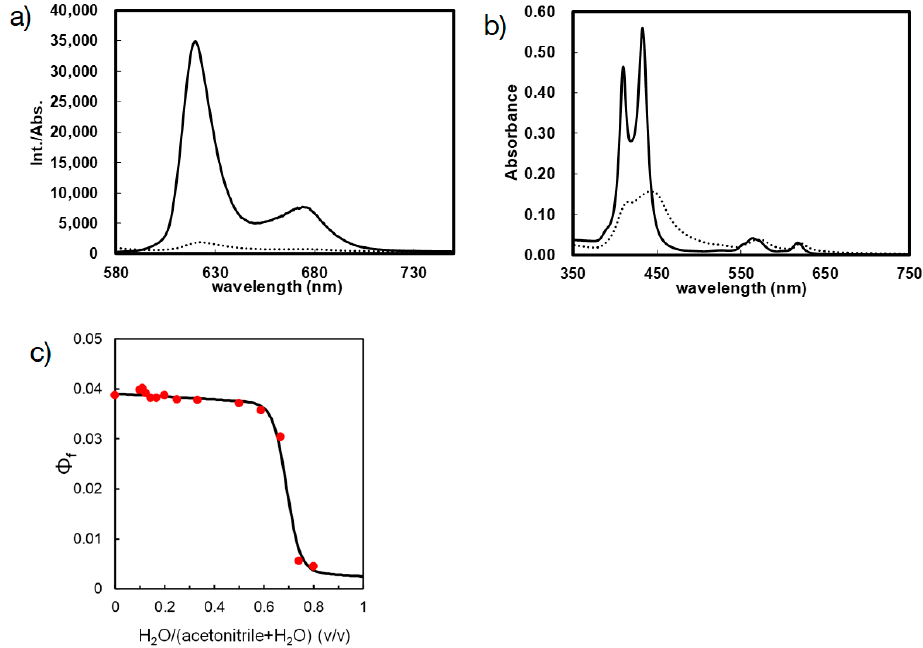
Figure 12. ( a ) Fluorescence (ex. 564 nm) and ( b ) UV-Vis absorption spectra of 5Zn in (plain) 100% acetonitrile and (dotted) a mixture of 80:20 vol / vol of water and acetonitrile. ( c ) Fluorescence quantum yields of 5Zn in a mixture of water and acetonitrile.